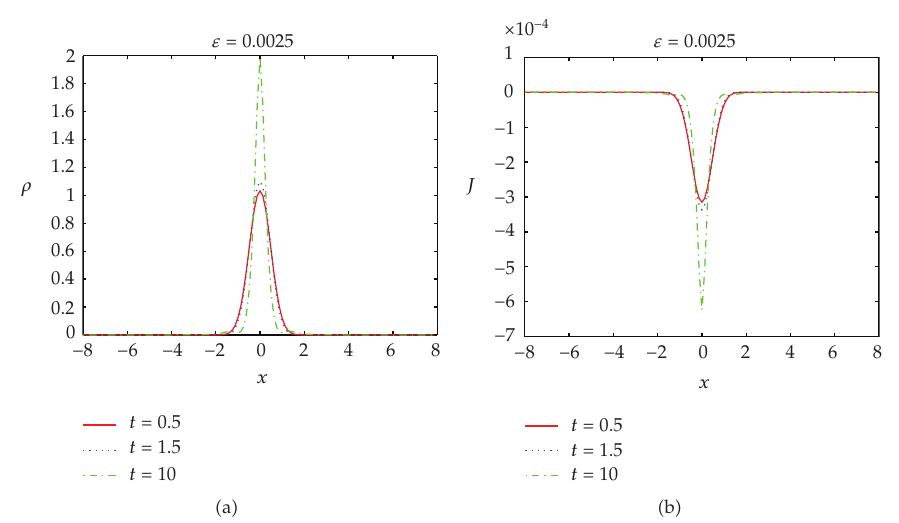
Figure 8: Numerical solutions of Example 5.2 by ED2/EP2 for the weak O (cid:3) ε 3 / 2 (cid:4) defocusing nonlinearity (cid:3) ε (cid:6) 0 . 0025 (cid:4) .